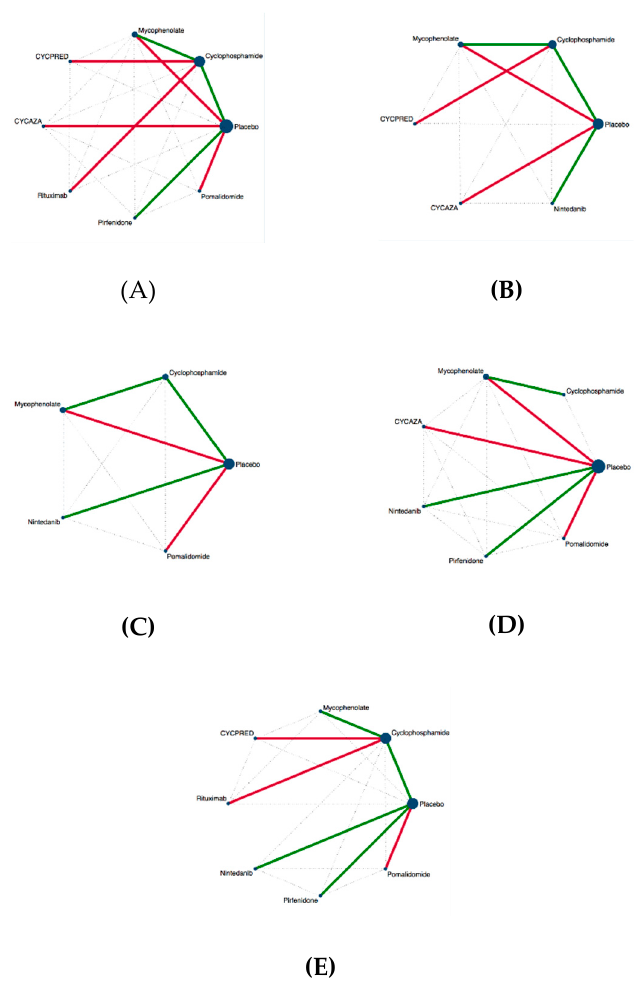
Figure 2. Network structures. ( A ), change in FVC % predicted network; ( B ), change in DLCO % predicted network; ( C ), number of patients with SAEs network; ( D ), number of patients discontinuing treatment for AEs network; ( E ), deaths network; Edges are colored according to the level of RoB of trials: green low RoB; red high RoB. Nodes were sized according to the number of participants. Dotted lines represent primary indirect comparisons.